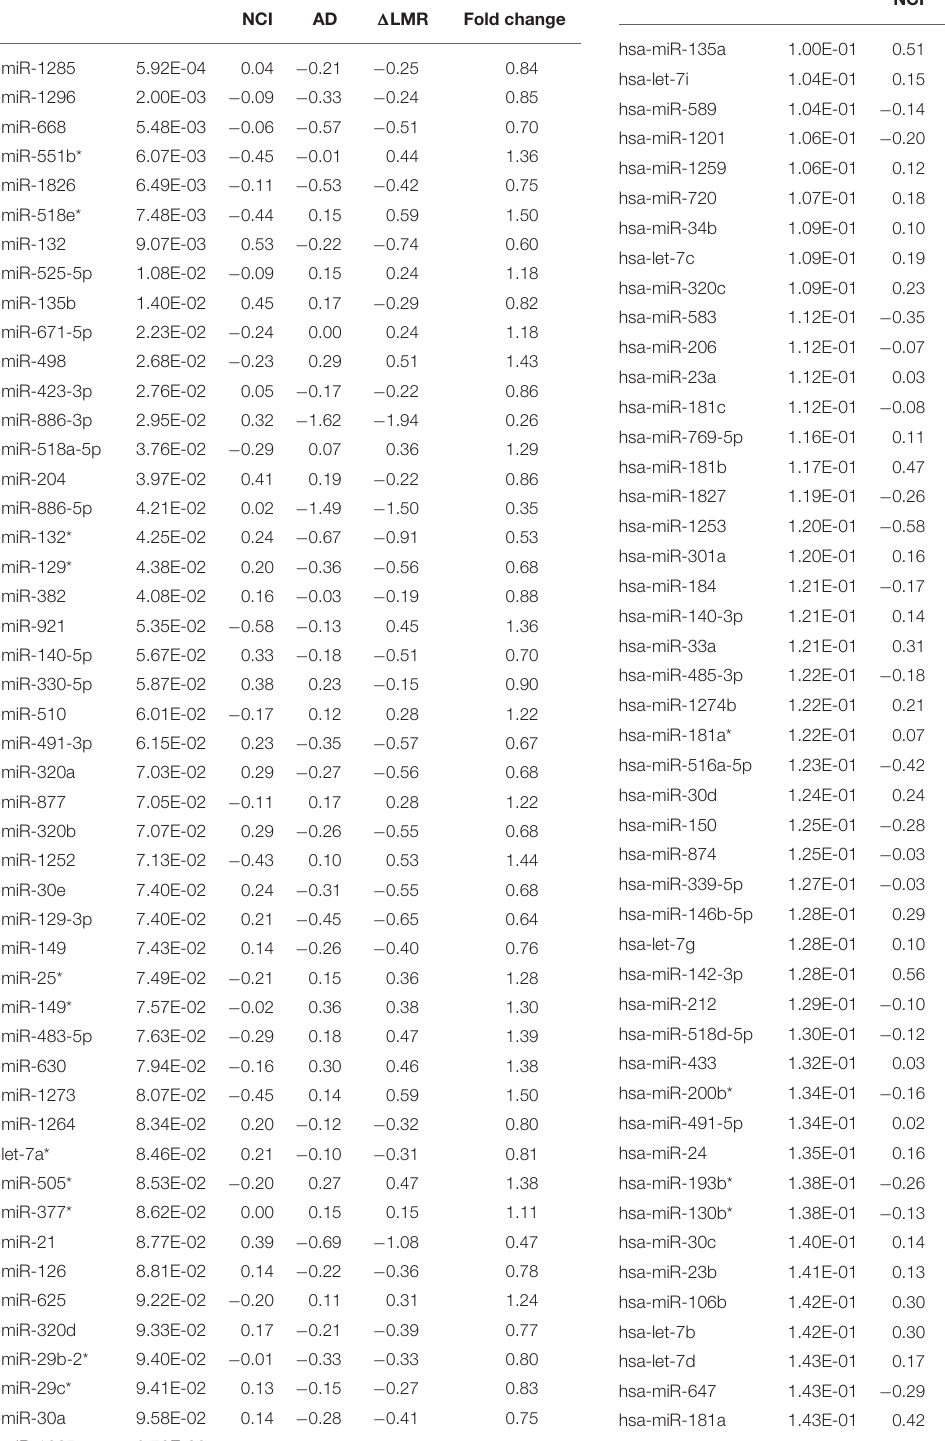
TABLE 2 | Top 100 miRNAs dysregulated in AD compared to NCI frontal cortex.